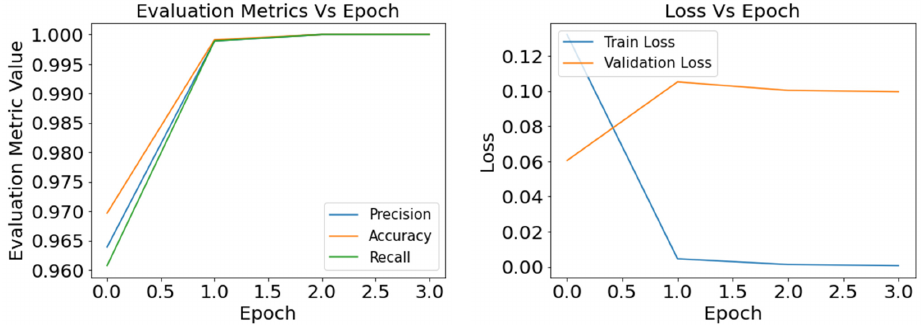
Figure 8. Defects classification with InceptionV3: result of the evaluation metrics and model loss for optimizer SGD and learning rate 0.001.